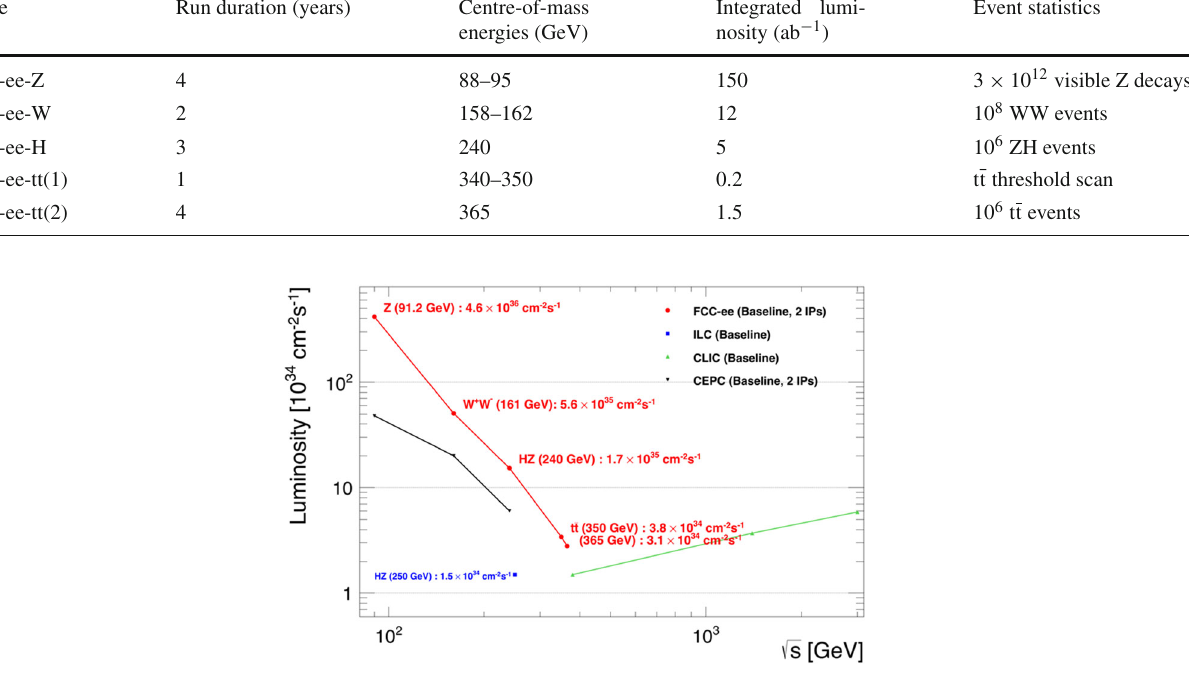
level of the design study, on the transverse polarisation for centre-of-mass determination at ppm level, a unique feature of circular